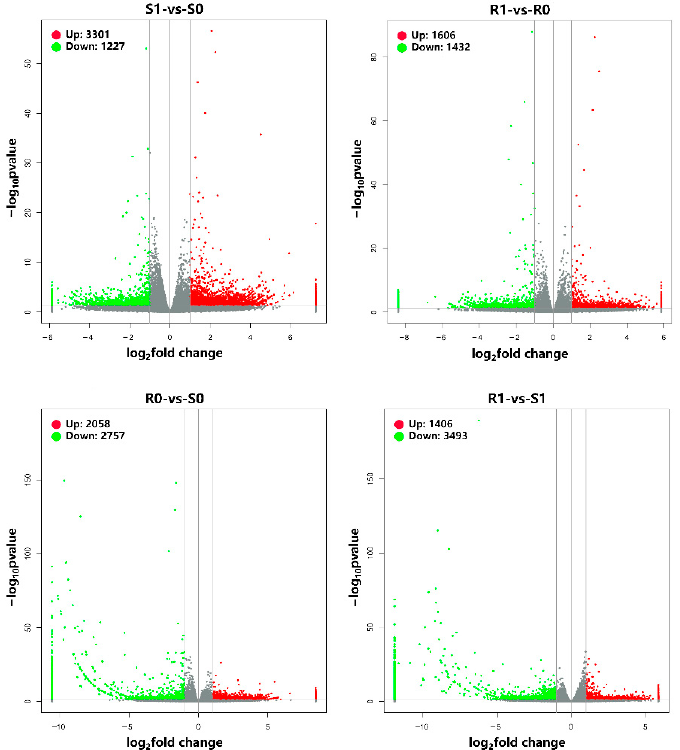
Figure 1. Volcano plots showing the transcriptional response of the four comparison groups. Differentially expressed genes (DEGs) are shown as red (upregulated) and green (downregulated) dots. Non-significantly expressed genes are shown as gray dots. The X -axis represents the value of log 2 (fold change), and the Y -axis shows the value of − log 10 ( p -value).